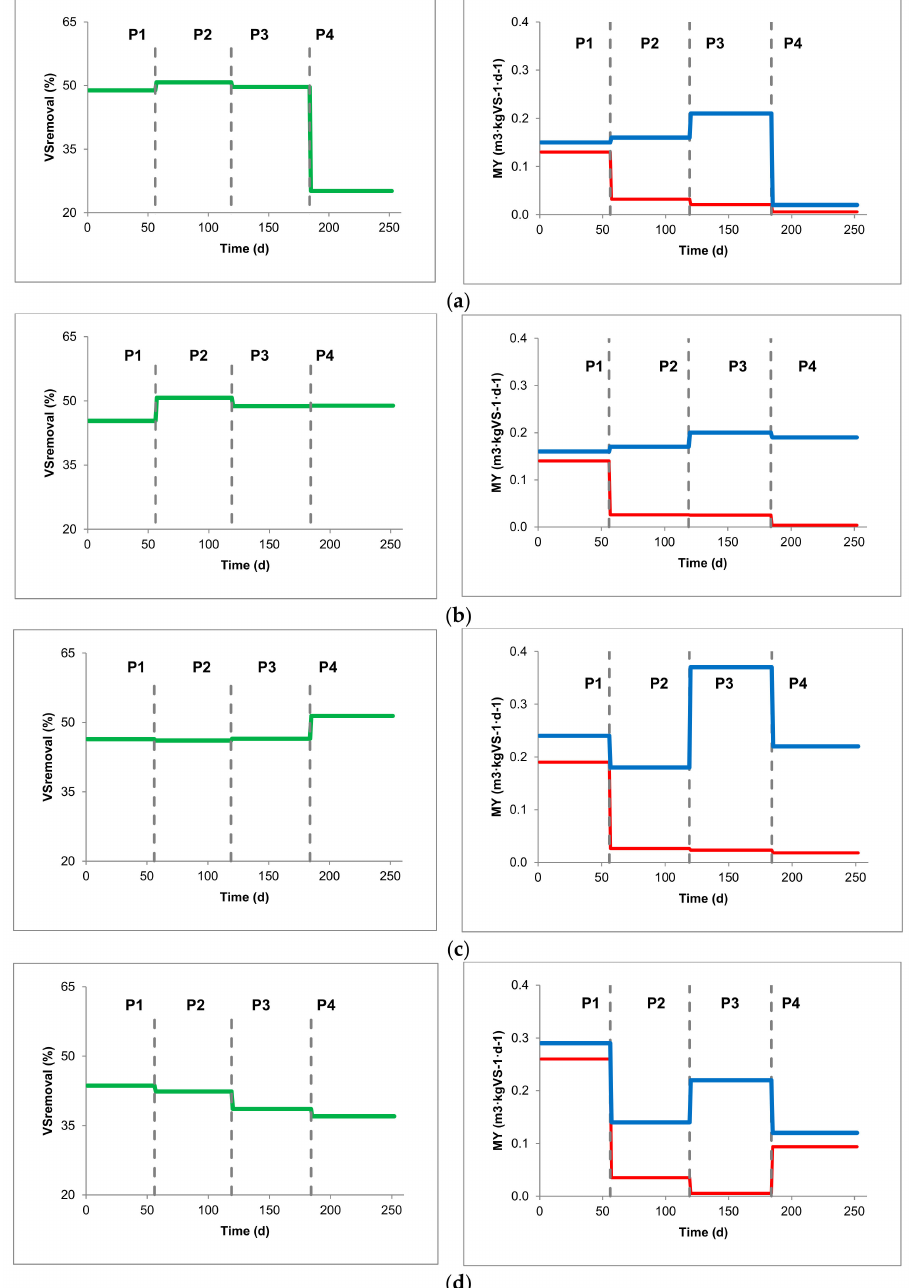
Figure 3. Evolution of organic matter removal ( VS removal ) and methane yield ( MY ) per reactor and period: ( a ) R1, ( b ) R2, ( c ) R3, ( d ) R4. Note: Vertical grey lines denote periods; green lines denote average values of VS removal e ffi ciency for each whole period; red and blue lines denote average values of MY registered by flowmeter and COD balance, respectively, for each whole